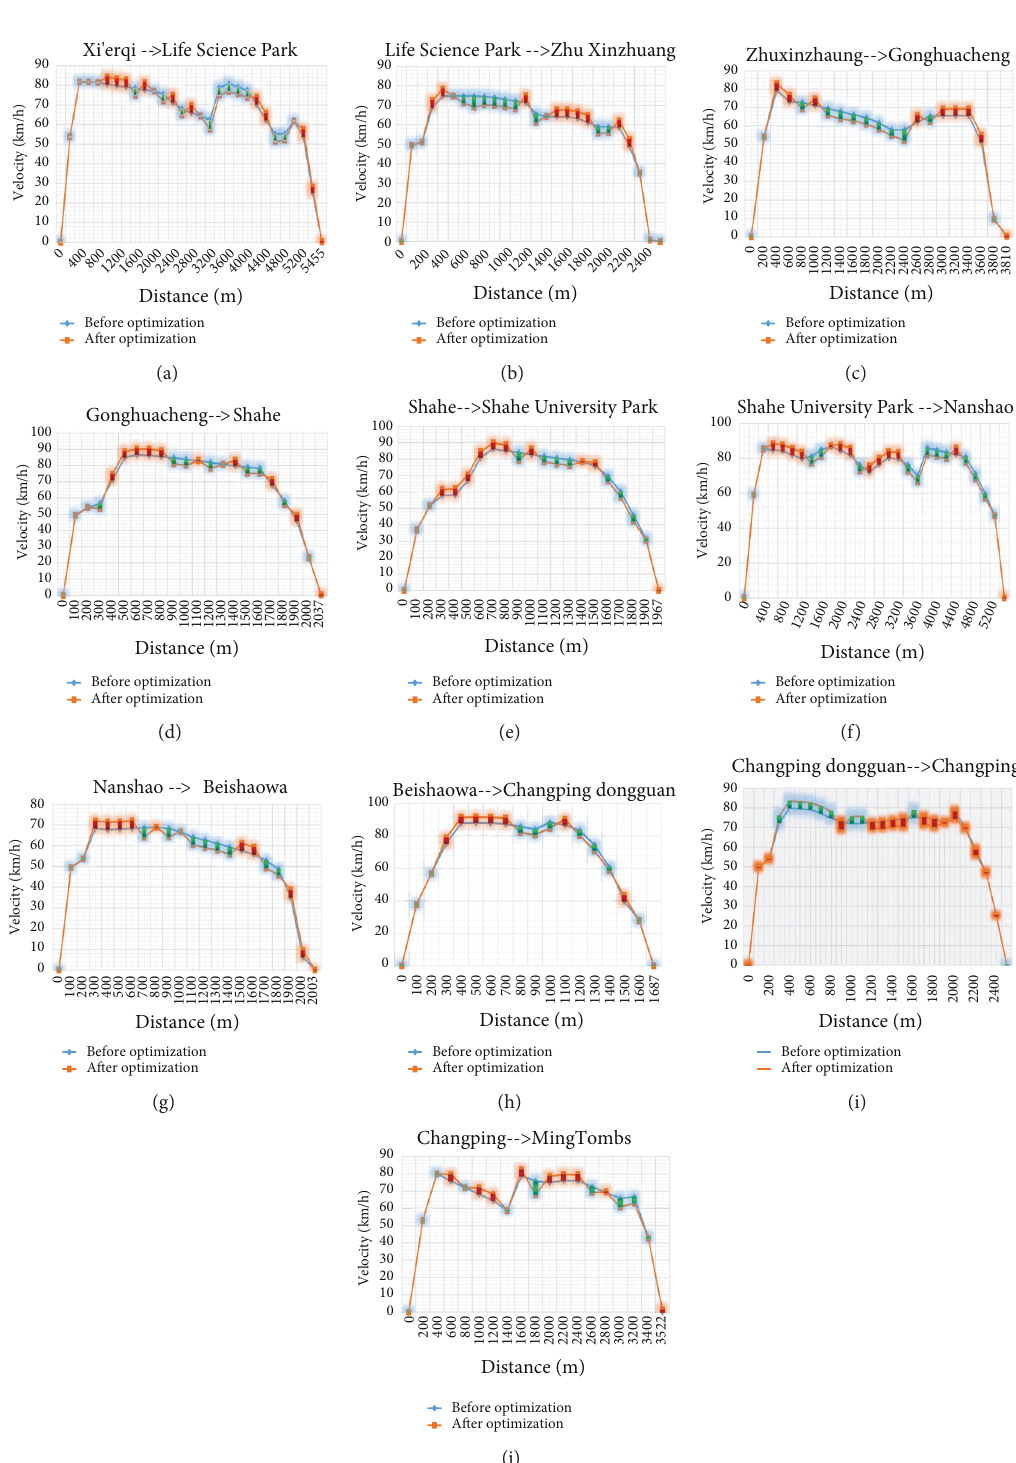
Operation sections with different distances should not have the same discrete interval. For longer section, the interval could be bigger. For example, distance of Xi’erqi- Life Science Park is 5455 m, and interval could be 200